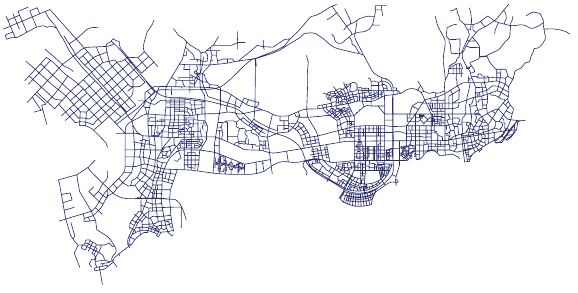
Figure 3: The transportation network of Shenzhen,